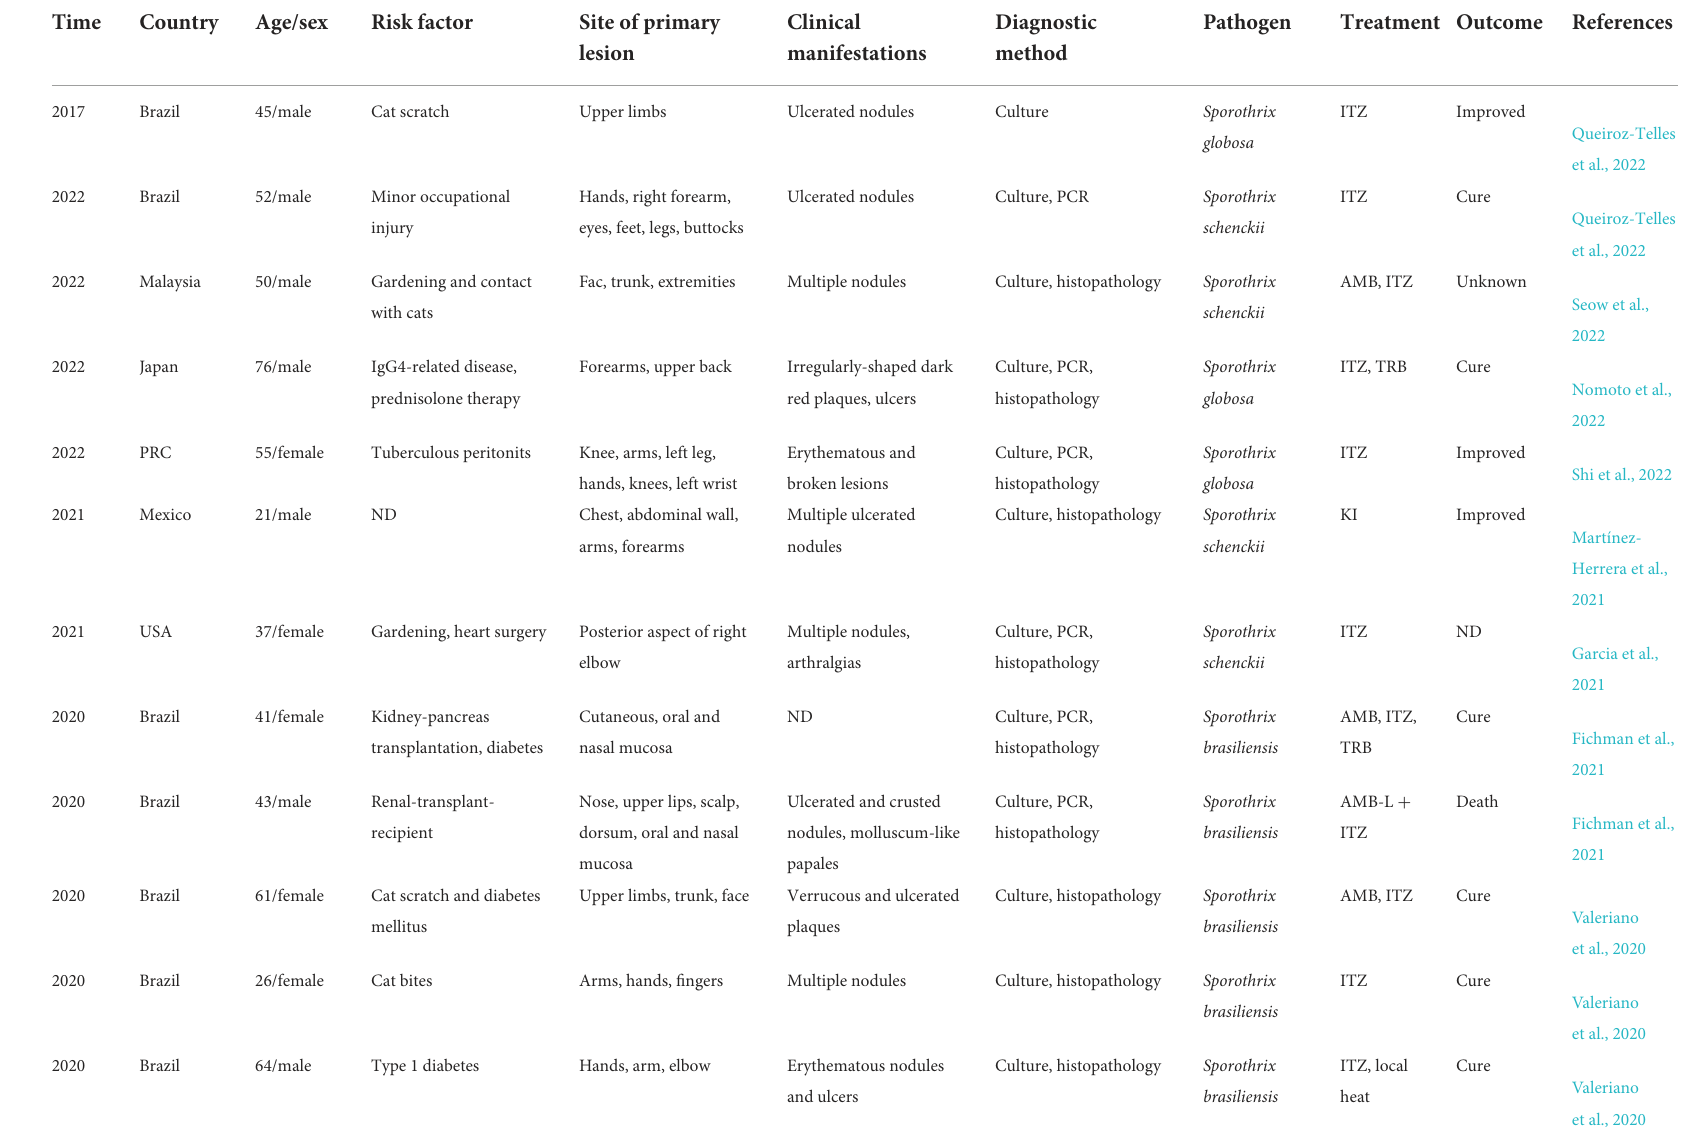
TABLE 1 Summary of reports on CDS in immunosuppressed and immunocompetent